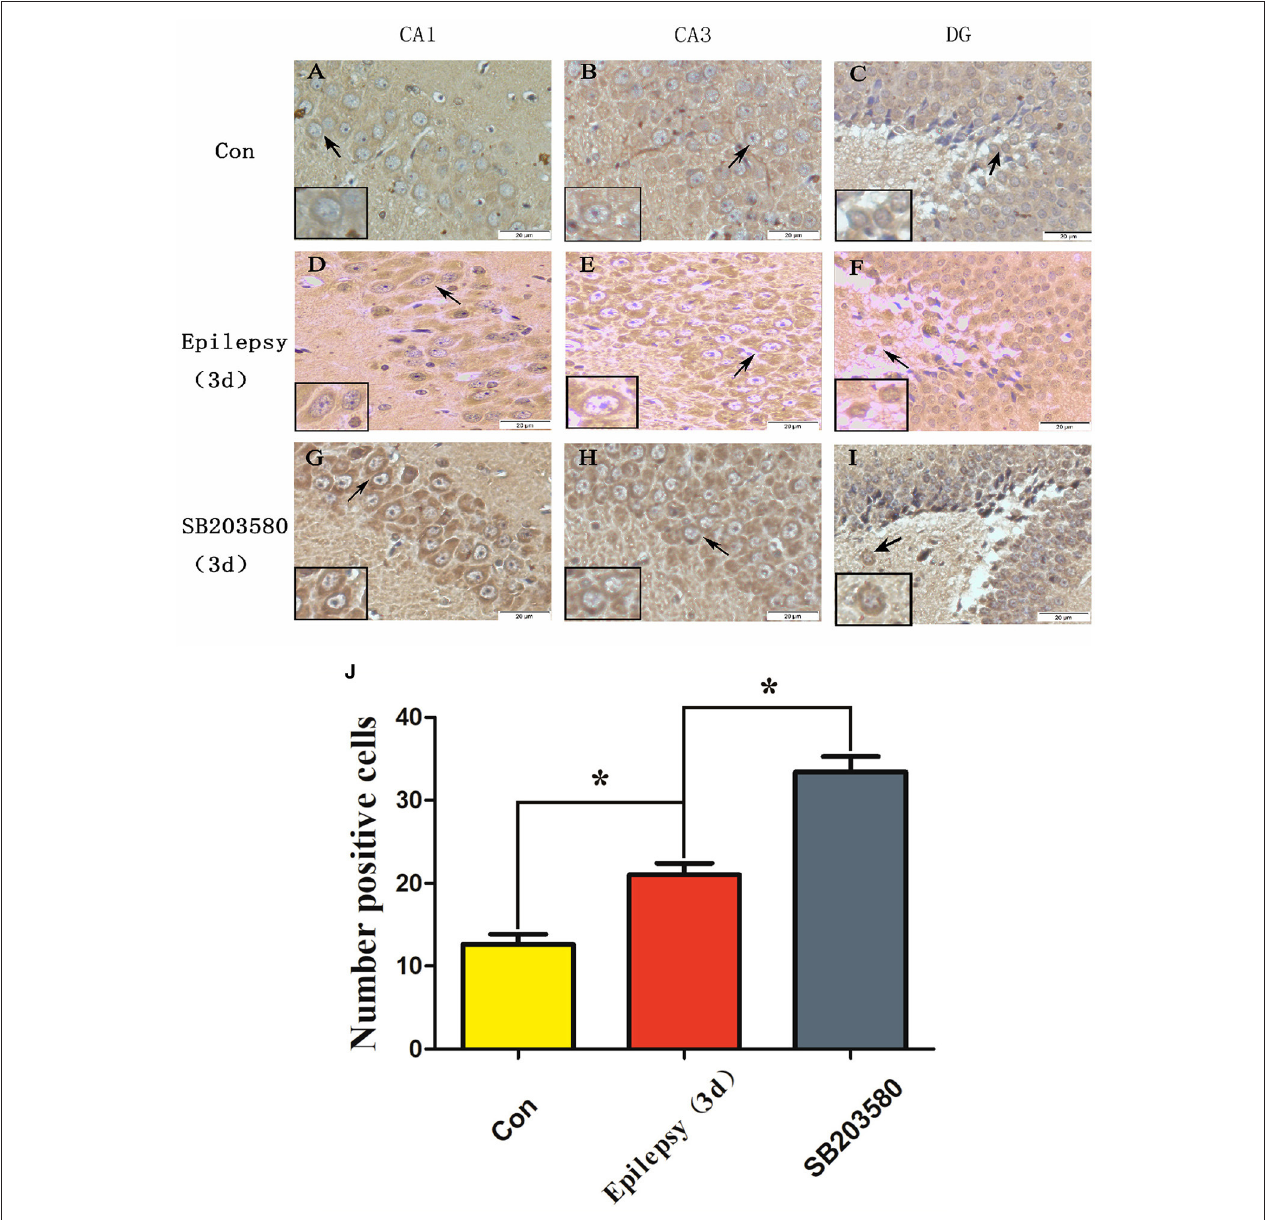
FIGURE 6 | Immunohistochemical detection of EAAT2 expression in the hippocampus (scale: 20 µ m). (A,D,G) show the CA1 hippocampal area; (B,E,H) show the CA3 hippocampal area; and (C,F,I) show the DG hippocampal area. Panel (J) shows the quantification of (A–I) . * P < 0.05 compared with the untreated control.